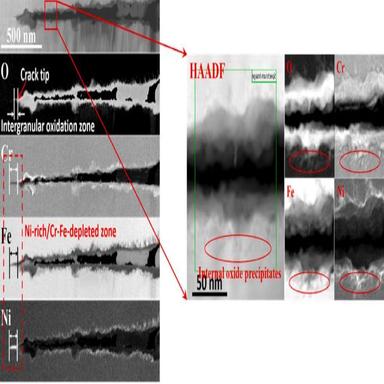
HAADF images and qualitative EELS elemental maps of representative SCC crack tips prepared from Fe-16Cr-11Ni alloy tested at (a) 360 ◦C and (b) 320 ◦C.